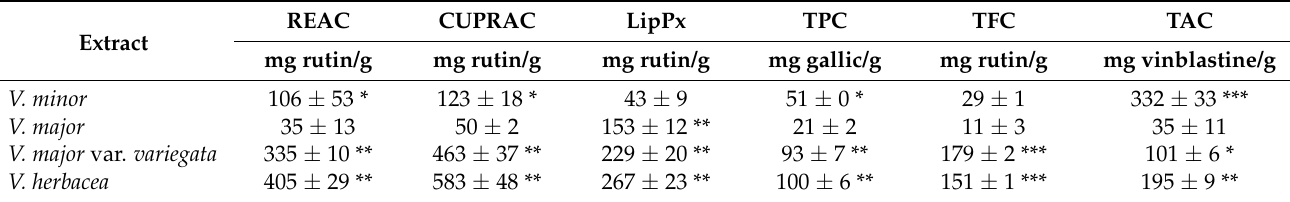
Table 2. Antioxidant activities and phytoconstituent content of Vinca minor , V. major , V. major var. variegata , and V. herbacea leaf extracts expressed as equivalents of standard for each assay.